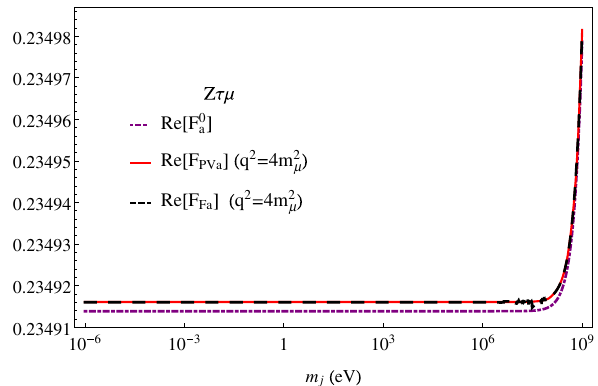
Fig. 2 Numerical evaluation of the F a function for the effective Z τμ vertex as a function of the neutrino mass, taking the minimal value of q 2 = 4 m 2 μ for the particular τ − → μ − μ − μ + channel. Black dashed linestandsforthenumericalevaluationofthe F a functionintermsofthe Feynman parameters depicted by F F (Eq. (11)), whereas the red line a corresponds totheevaluationintermsofthePaVefunctionsrepresented by F PV (Eq. (19)). We have found some numerical instabilities for the a evaluation of the F F function in the region 0 . 01 GeV < m j < 0 . 1 a GeV. On the other hand, better precision is achieved in the evaluation of the F PV function with the help of the Looptools package. In order to a performacomparisonwiththeapproximationdoneinRef.[15],wealso show the complete F 0 a given by the Eqs. (6) or (7) (purple dotdashed